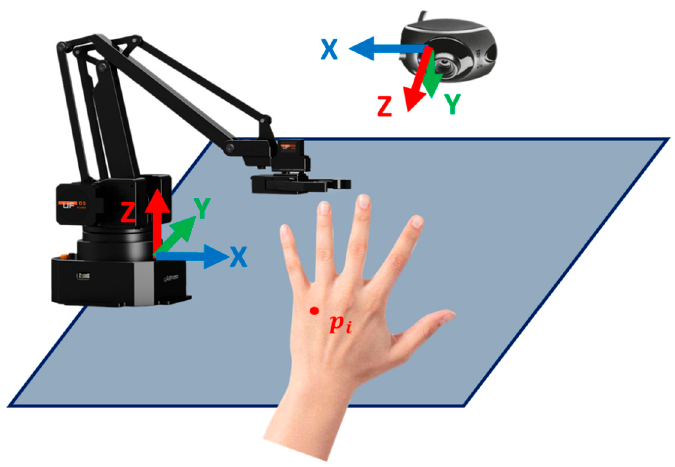
Figure 11. Diagram of the practical